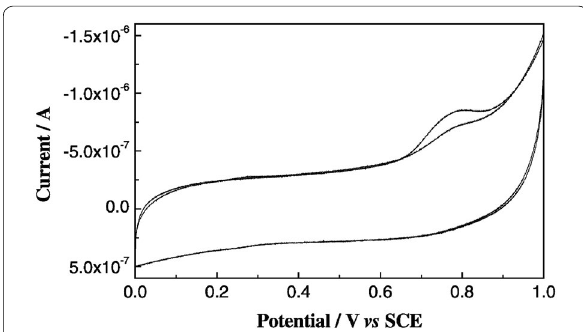
Fig. 1 Voltammetric behavior of Hela cells, the scan rate was 30 mV s − 1 , the temperature was 37 7.3 10 5 mL − 1 (Reprinted with permission from [45]. Copyright @ × 2001